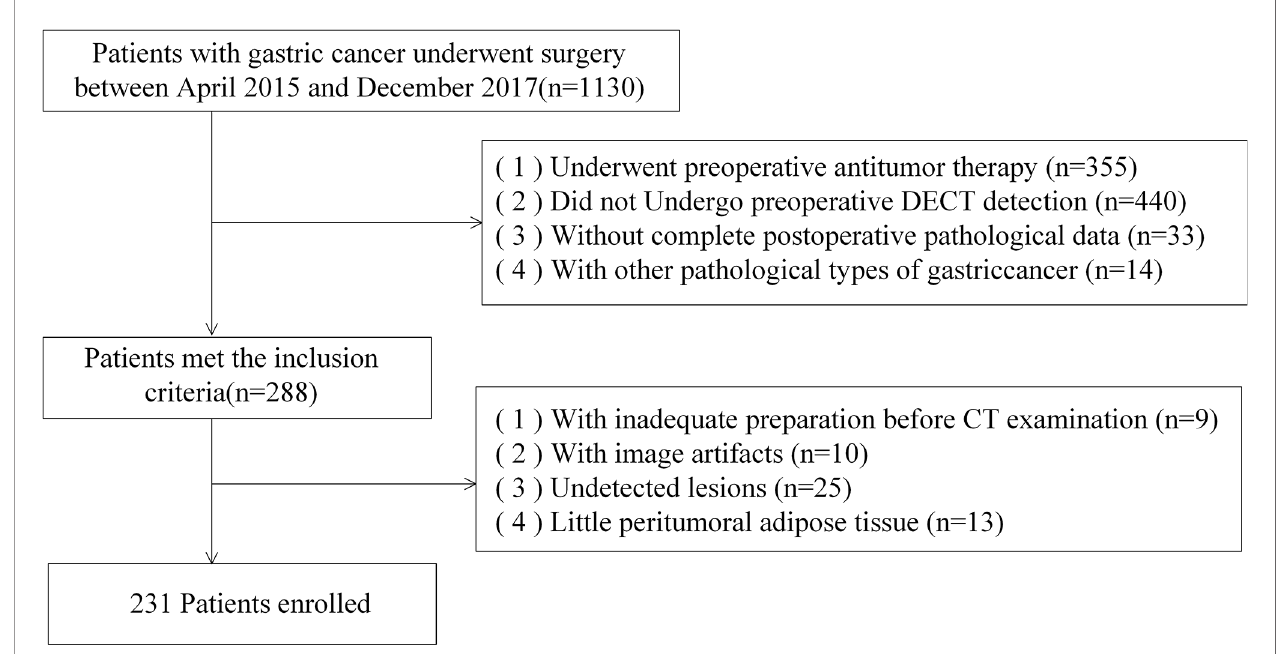
FIGURE 1 | Flowchart of patient